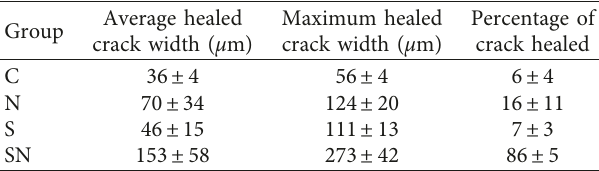
Figure 8: Images of cracks before and after healing: (a) group C; (b) group SN. Table 3: Summary of the crack